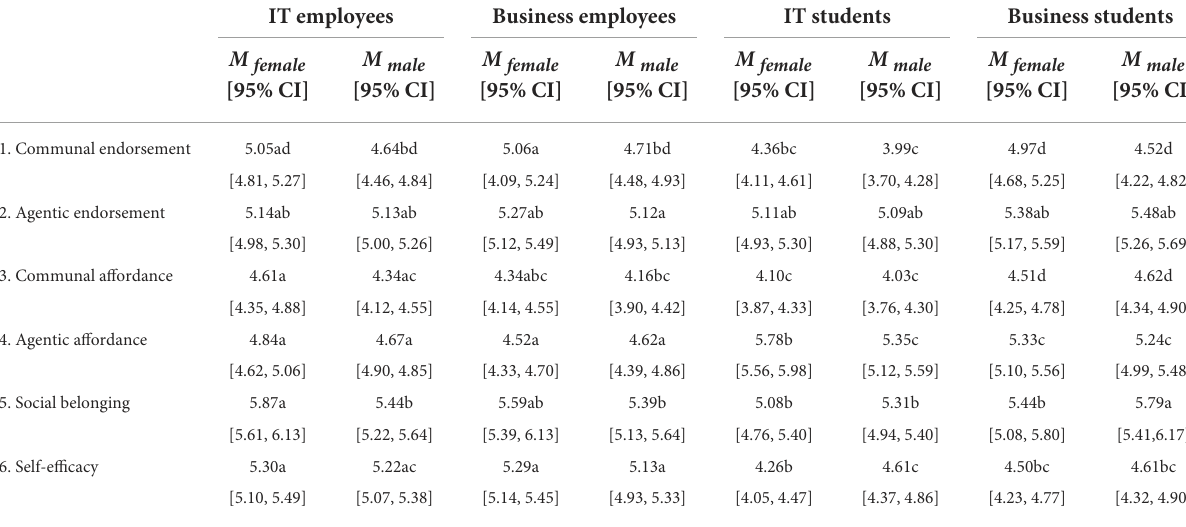
TABLE 5 Means and confidence intervals for all dependent variables for female and male employees and students in IT and business fields. IT